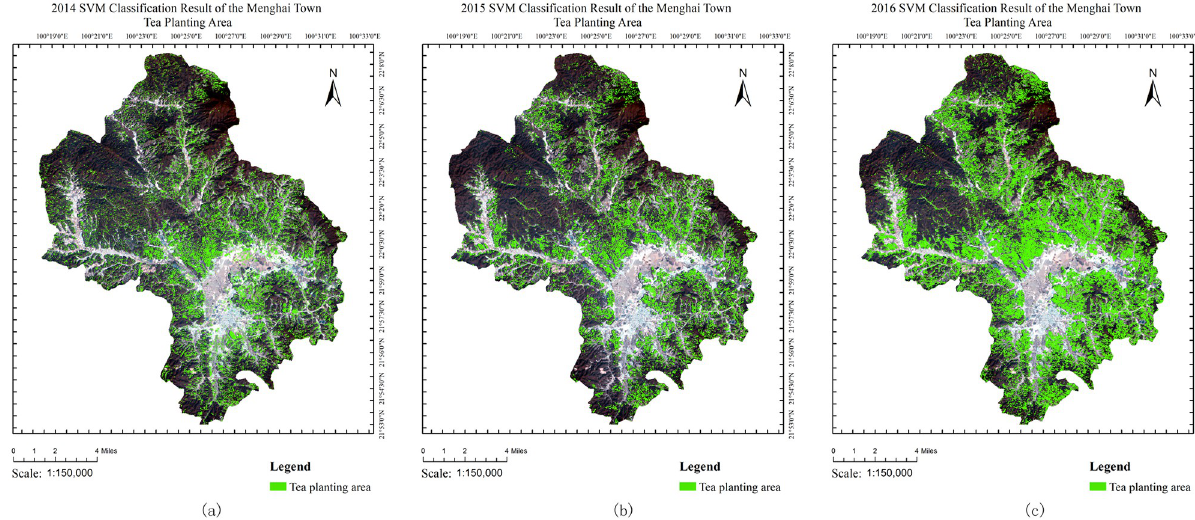
Fig 10. Extraction results in (a)2014 (b)2015 and (c)2016. The base map of the LandSat8 OLI images with the following composition:R (4),G (3) and B (2). The LandSat8 OLI images were downloaded from USGS National Map